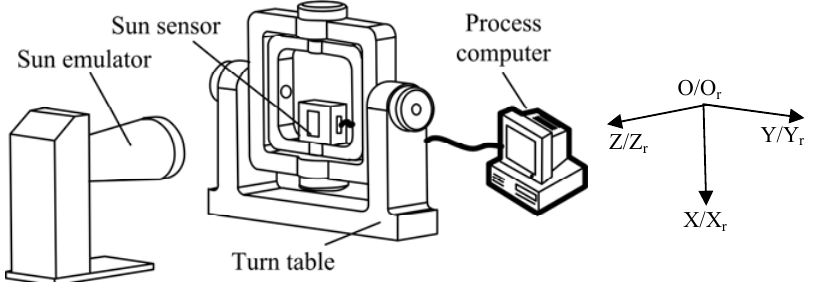
Figure 9. Setup of calibration